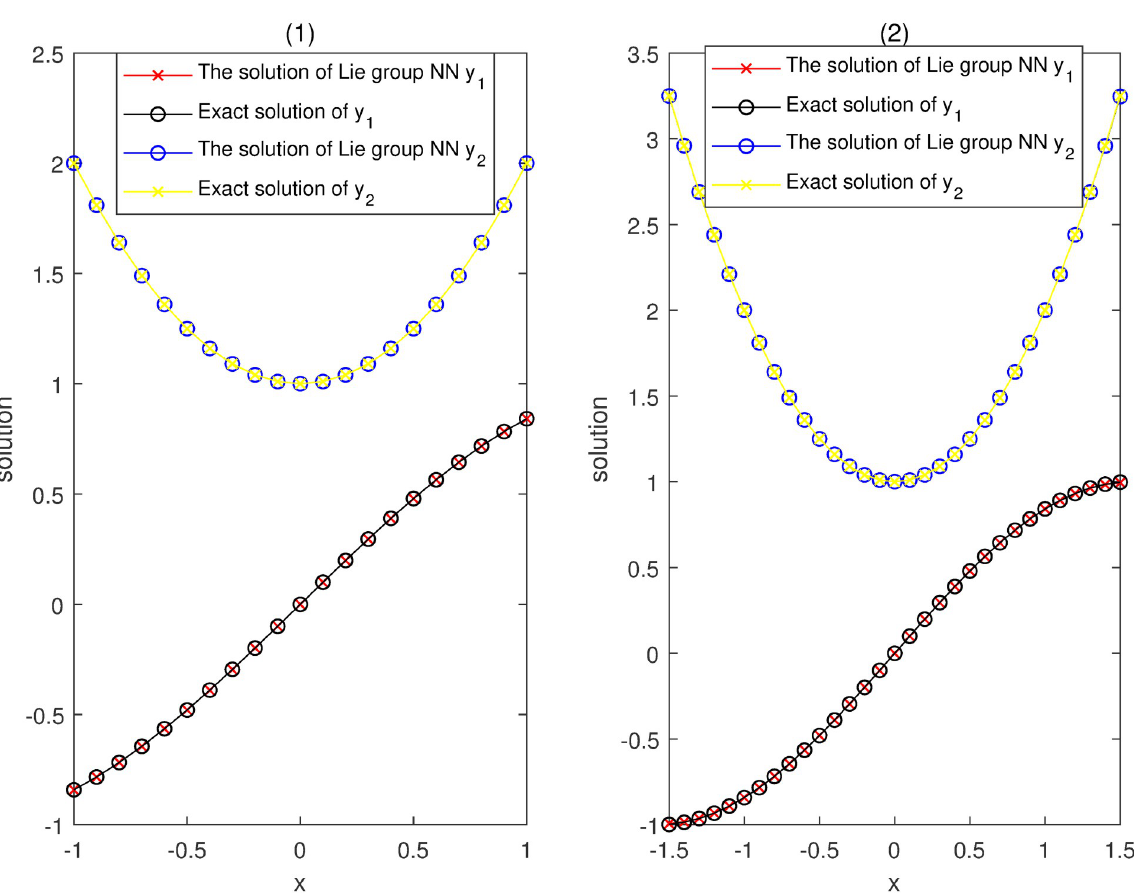
Fig 2. Comparison between our solutions ^ y